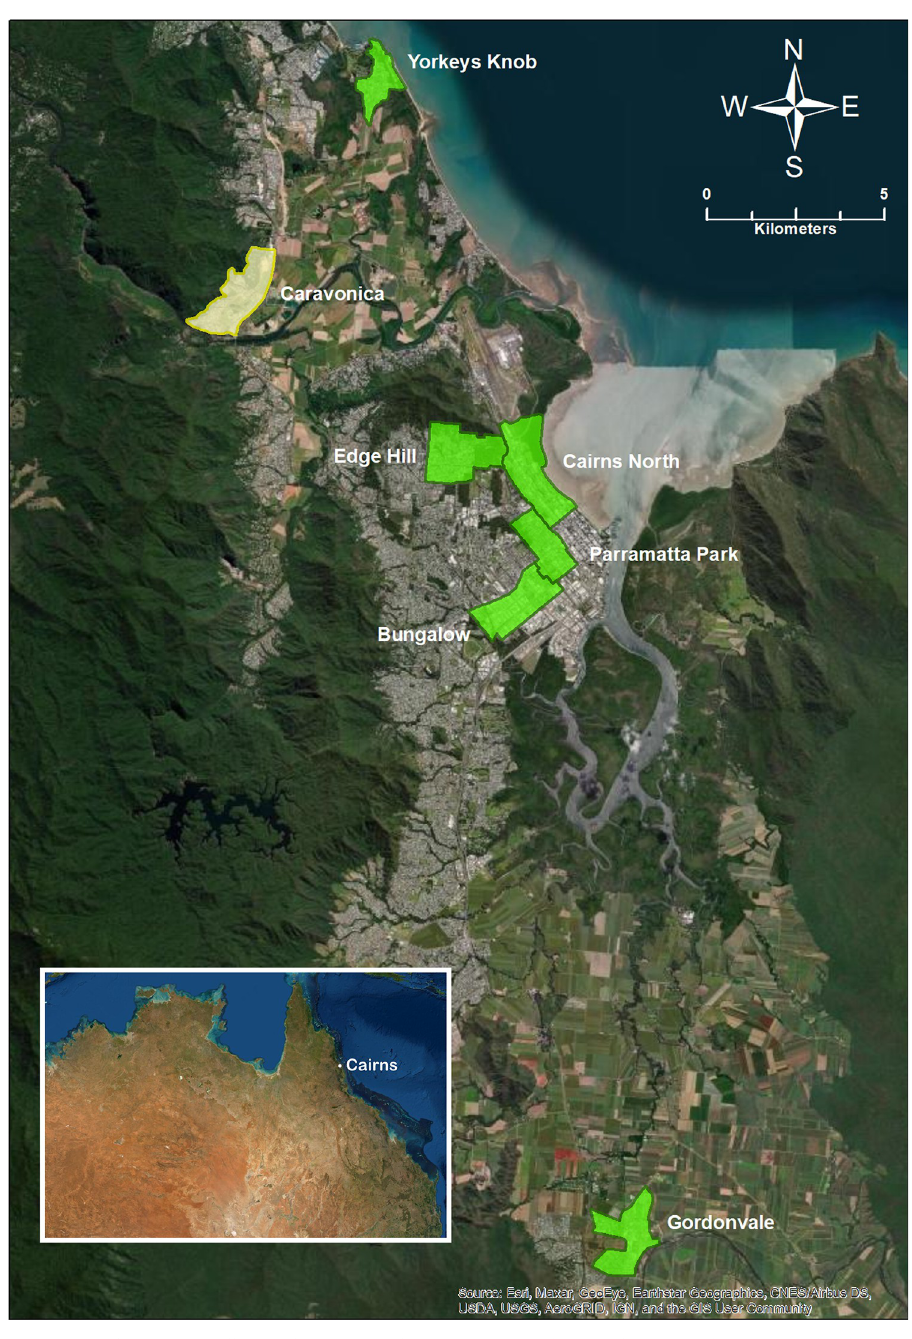
Fig 1. Map of mosquito collection locations in the Cairns Regional Council area, northern Queensland, Australia. Wolbachia -infected mosquitoes were released in the suburbs shaded green. There had been no releases of Wolbachia infected mosquitoes in Caravonica (shaded yellow) up until at least April 2019, when the collections for the current study were undertaken. Source of baselayer is https://www.arcgis.com/home/item.html?id= 10df2279f9684e4a9f6a7f08febac2a9. This map was created using ArcGIS software by ESRI (www.esri.com). ArcGIS and ArcMap are the intellectual property of Esri and are used herein under license. For more information about Esri software, please visit www.esri.com.